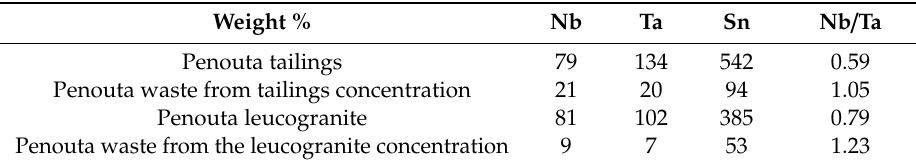
Table 2. Chemical composition of the Penouta tailings and the leucogranite outcropping ore including the Nb, Ta, and Sn concentrations and the Nb / Ta ratio used in the experiments in this work.